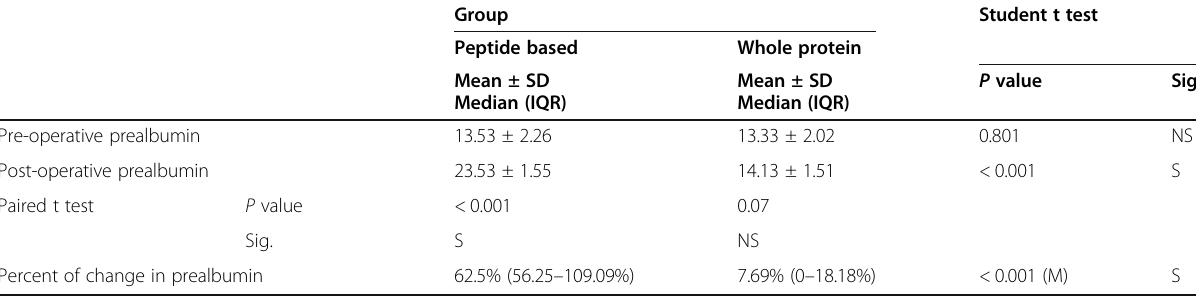
Table 2 Pre- and postoperative pre-albumin levels